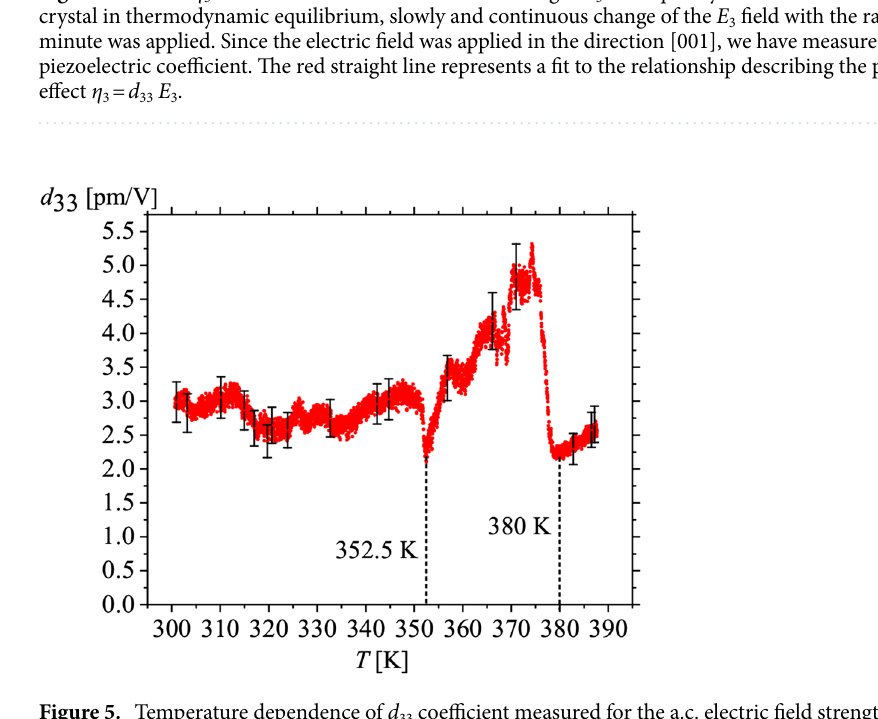
Figure 5. Temperature dependence of d 33 coefficient measured for the a.c. electric field strength of 4 kV/cm and the frequency of 160 Hz. Experiment has been performed for the same crystal for which data at 300 K